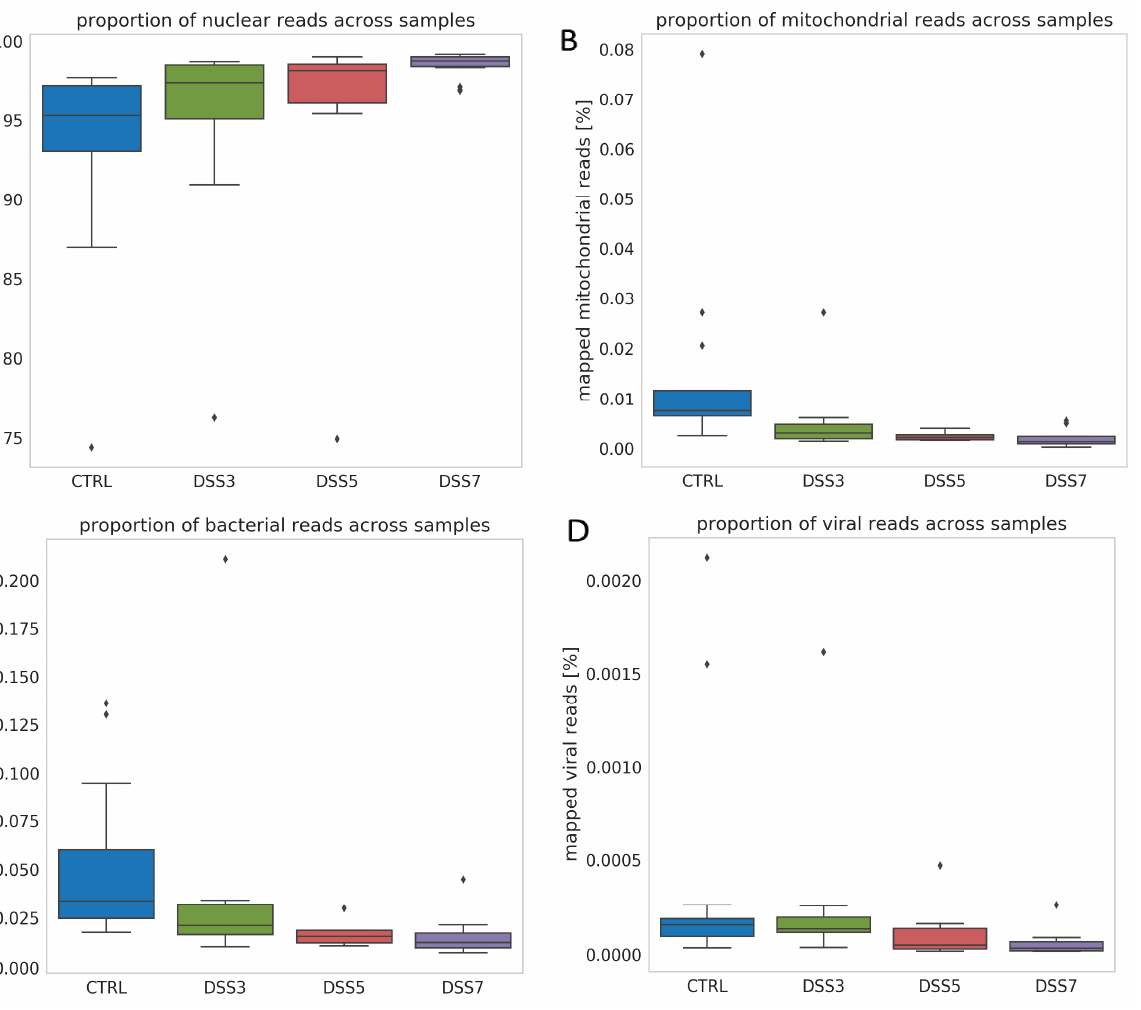
Figure 5. Origin of ecDNA. ( A ) Relative proportion of mapped nuclear reads shows an increasing trend from CTRL toward DSS7. Relative proportion of ( B ) mitochondrial, ( C ) bacterial and ( D ) viral mapped reads shows decreasing trend from CTRL towards DSS7 group. Graph shows proportion of reads relative to total number of mapped reads.